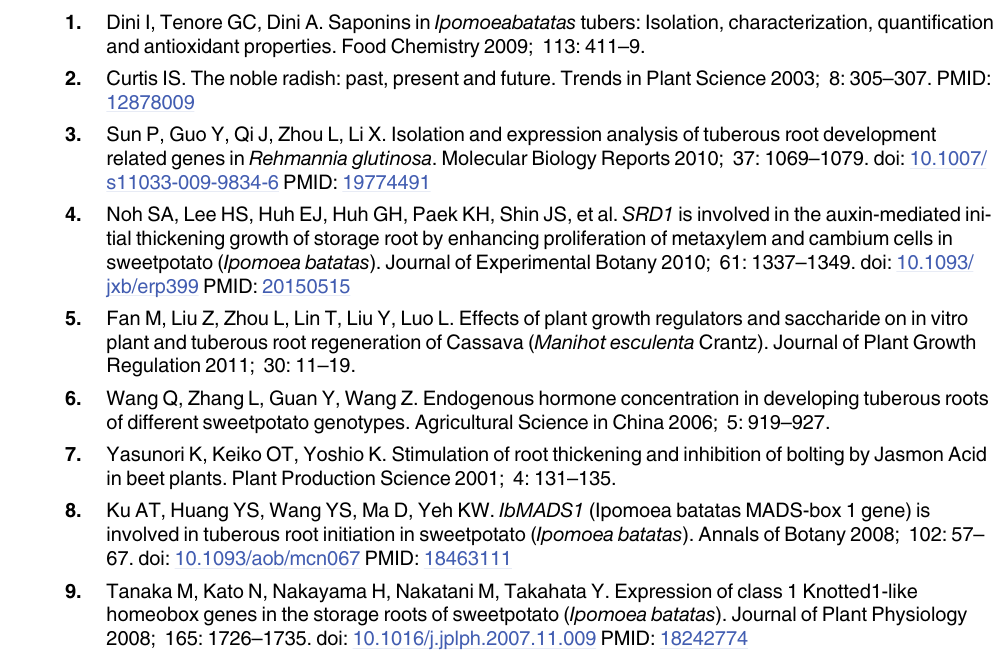
S5 Table. Distribution of sRNAs among different categories in the six libraries. S6 Table. miRNAs identified in each sRNA libraries. The genes with Log2 ratio were DEGs in the corresponding comparison. Novel miRNAs shown in bold are ones having miRNA (cid:4) identified in the study. S7 Table. Bra-miRNAs identified in each sRNA libraries. S8 Table. DEMs and their target gene. Target genes shown in bold red are DEGs with their expression profiles matched up with their corresponding DEMs, while those shown in bold blue are DEGs with their expression profiles not matched up with their corresponding DEMs. S9 Table. Pathway enrichment analysis of target genes of DEMs detected in both replicates (top three pathways are shown for each